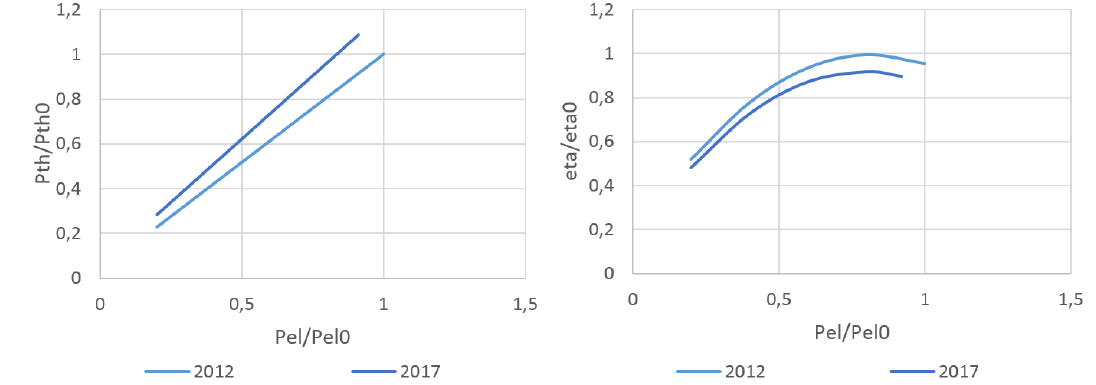
Figure 7. Performance trend of the engine at 15 °C ambient temperature for (a) electrical and thermal power and (b) efficiency, as a function of electrical